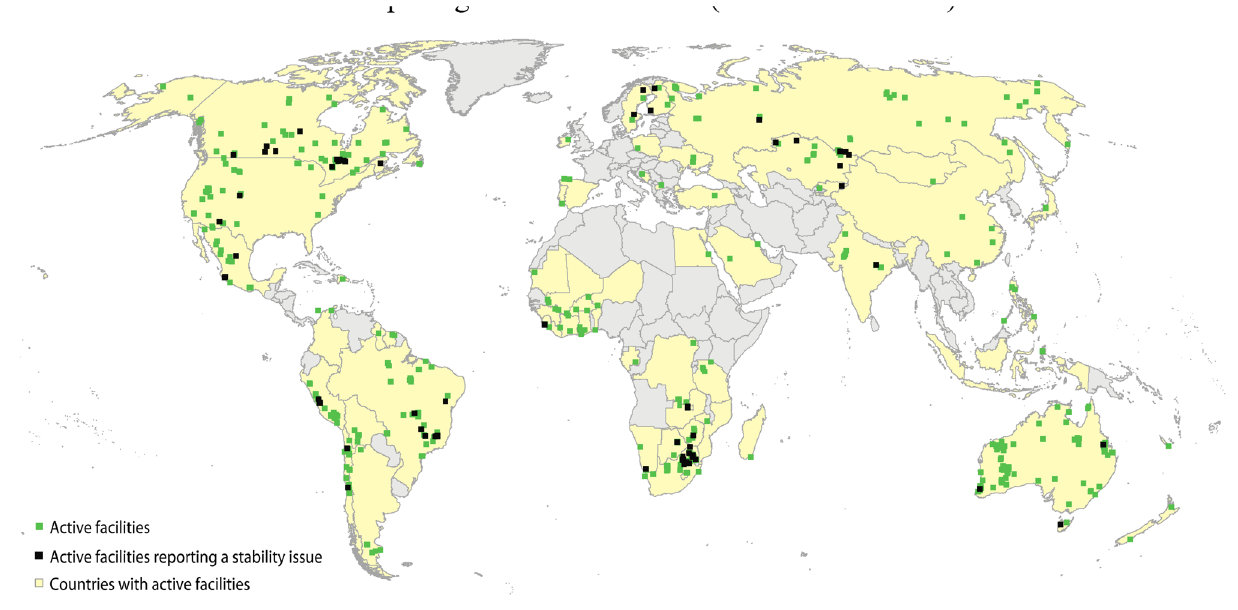
Figure 2. Map of active tailings facilities. Location of active facilities and active facilities reporting a stability issue. Shaded countries indicate those where an active tailings facility is reported in the dataset. The map illustrates the wide geographic representation of the surveyed facilities, as well as the under-representation of facilities in countries such as China, India and Chile, where a higher proportion of companies are not publicly- listed.